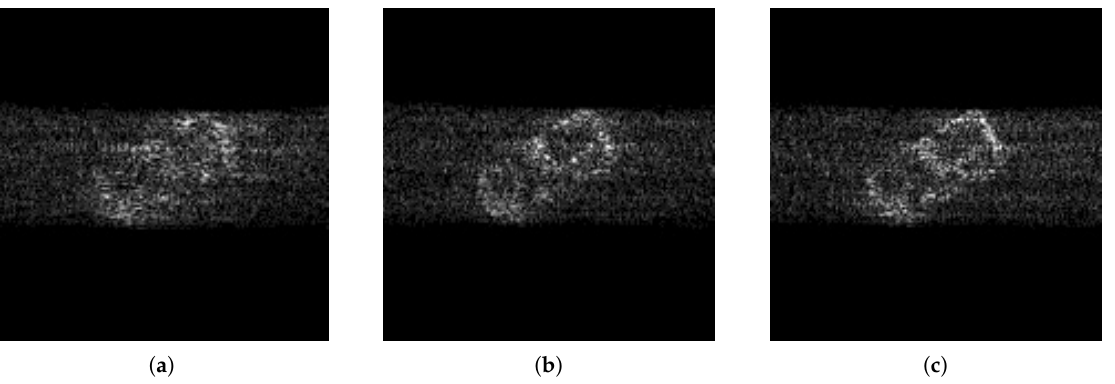
Figure 20. Refocusing results based on target trajectory (horizontal is azimuth; vertical is range).